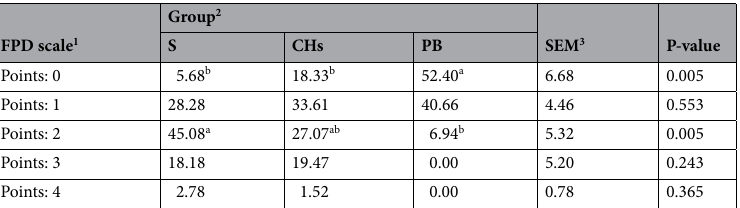
Table 3. Footpad dermatitis assessment of broiler chickens (% of the group). a,b Different letters in the row indicate statistically significant differences between the groups, P-value < 0.05; letters are given from the highest (a) to the lowest value (…) ; 1 , the method was based on the Welfare Quality Project (based on photography, Welfare Quality, 2009, Butterworth, A. from the University of Bristol, North Somerset, UK), described by Rushen et al. 29 ; 2 , S, chopped wheat straw bedding; CHs, crude coffee husks bedding; PB, pelleted bedding with 50% of chopped wheat straw and 50% of coffee husks; 3 , SEM, standard error of the mean.